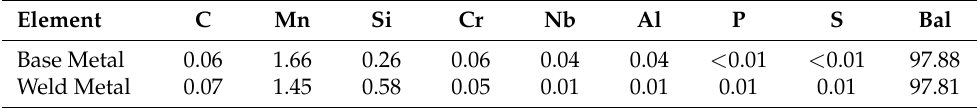
Table 1. X60 base metal and (girth) weld metal chemical composition. Bal represents Fe. The data are taken from